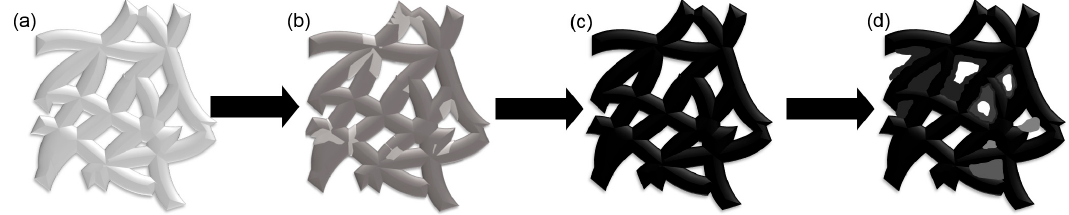
Figure 3. Schematic drawing of morphological evolution of GO at different deposition voltages ( a ) nickel foam; ( b ) GO was deposited on nickel foam at 40 V; ( c ) GO was deposited on nickel foam at 60 V; ( d ) GO was deposited on nickel foam at 80 V.